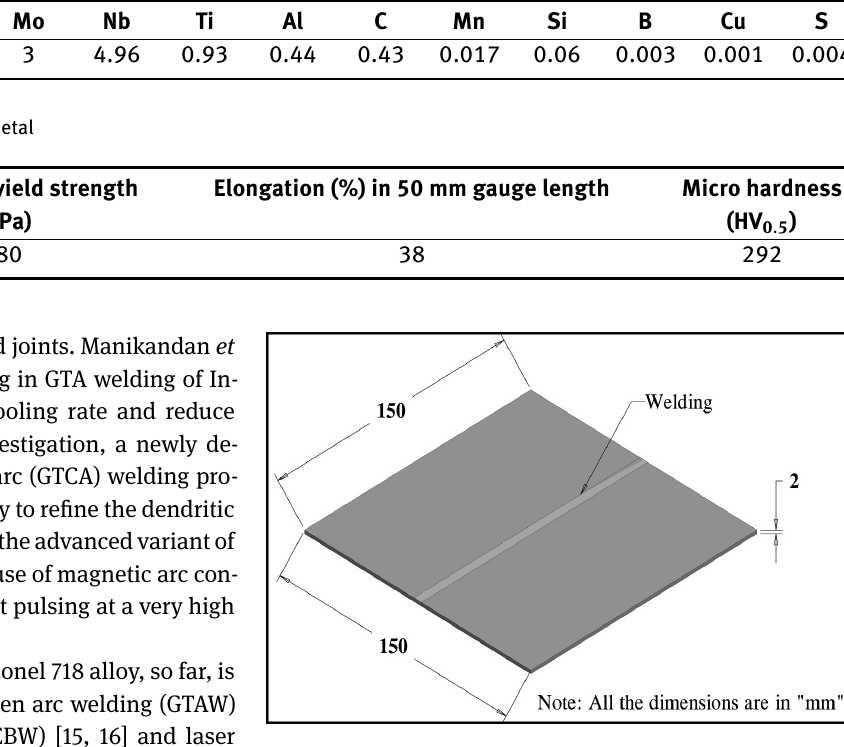
Figure 1: Joint configuration used in this investigation